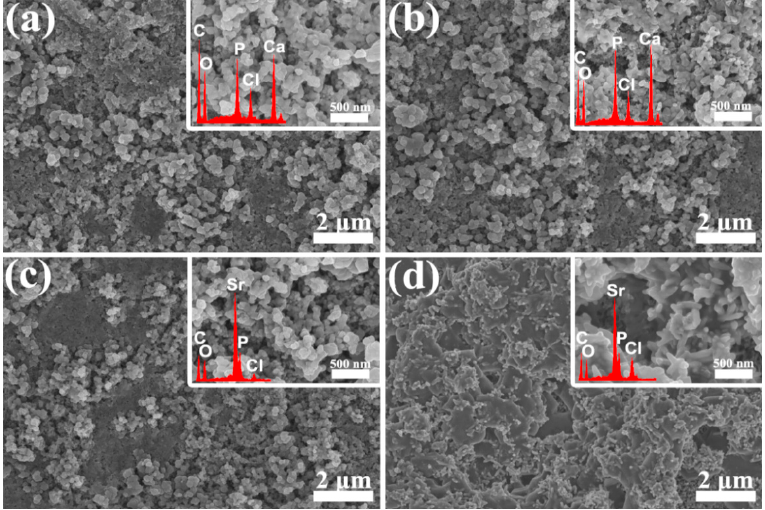
Figure 6. SEM morphology of synthesized coatings: ( a ) HA-1, ( b ) HA-2, ( c ) SrHA-1, and ( d ) SrHA-2. The SrHA-2 coating showed a nanorod morphology (inset), which was different from the other three (nanoparticles).